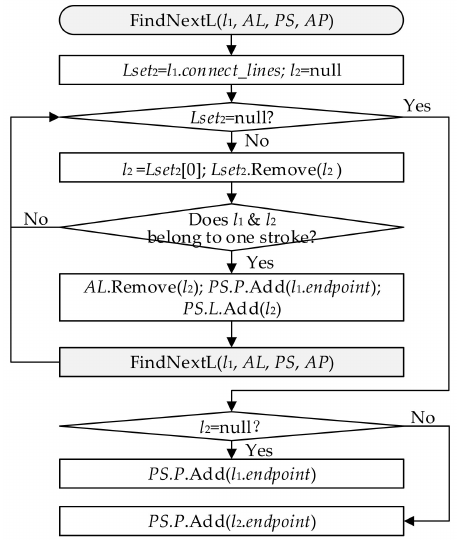
Figure 3. Algorithm program flowchart for each pipe stroke